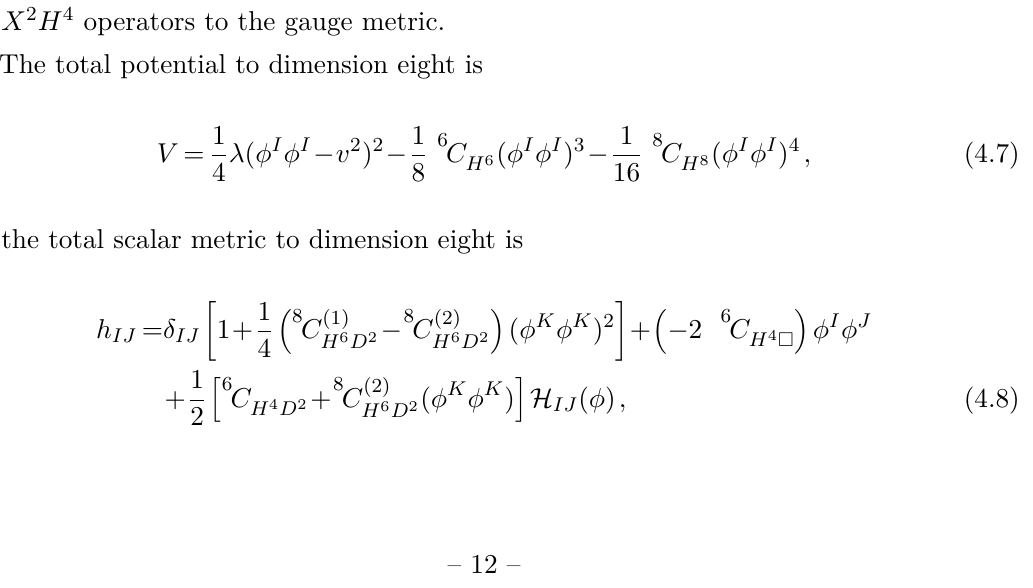
Table 2 . Bosonic dimension-four operators in the SM (and the SMEFT). The operator 4 R redundant, and can be eliminated by integration by